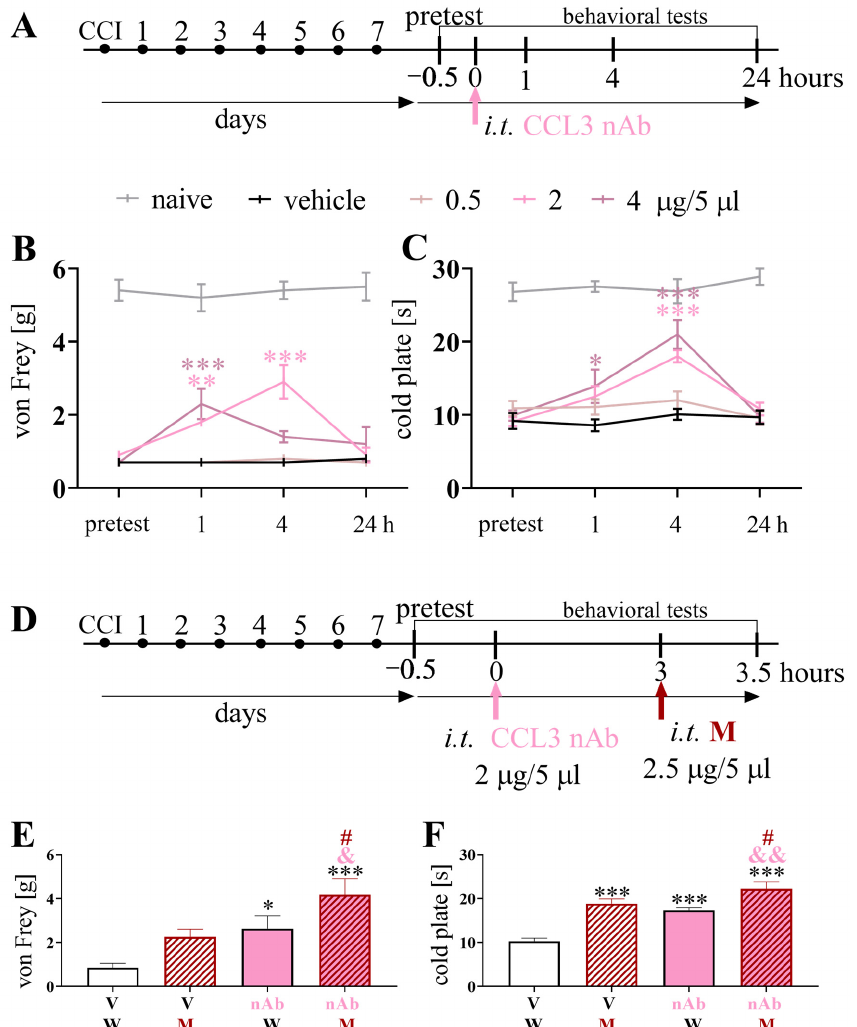
Figure 3 Figure 3. The effects of CCL3 neutralizing antibody administered intrathecally (i.t.) according to timeline ( A ), at doses of 0.5, 2, and 4 µ g/5 µ L on mechanical ( B ) and thermal ( C ) hypersensitivity, and the influence of a CCL3 neutralizing antibody at a dose of 2 µ g/5 µ L plus morphine 2.5 µ g/5 µ L on mechanical ( E ) and thermal ( F ) hypersensitivity, administered according to timeline ( D ), 7 days after CCI in mice. The data are presented as the mean ± SEM (naive n = 5; CCI n = 7–8). The results were evaluated using one-way ANOVA followed by Bonferroni’s post hoc test for comparisons of selected pairs. * p < 0.05, ** p < 0.01, and *** p < 0.001 indicate significant differences vs. V- treated group at each of the investigated time points: 1, 4, and 24 h for ( B , C ) graphs; * p < 0.05 and *** p < 0.001 indicate significant differences vs. V + W-treated group for ( E , F ) graphs; # p < 0.05 indicates significant differences between the V + M- and nAb + M-treated groups for ( E , F ) graphs; and & p < 0.05 and && p < 0.01 indicate significant differences between the nAb + W- and nAb + M-treated groups. Abbreviations: V: vehicle (PBS); W: vehicle ( aqua pro injectione ); nAb: neutralizing antibody; M: morphine; CCI: chronic constriction injury of the sciatic